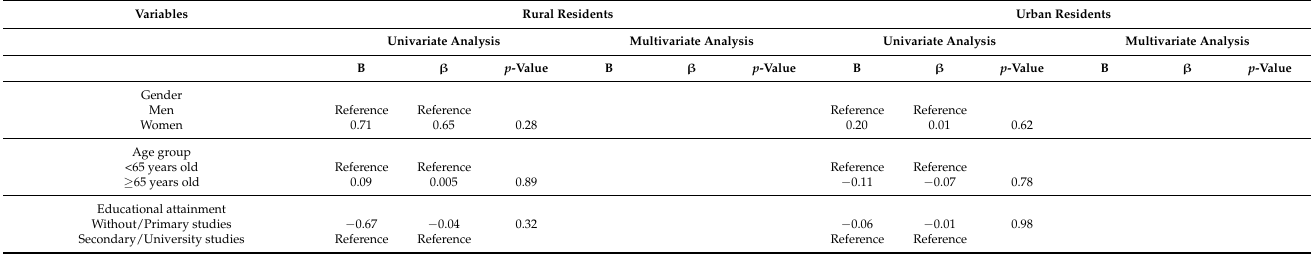
Table 4. Association between PSS, sociodemographic factors and health-related determinants in rural and urban cancer patients ( n =